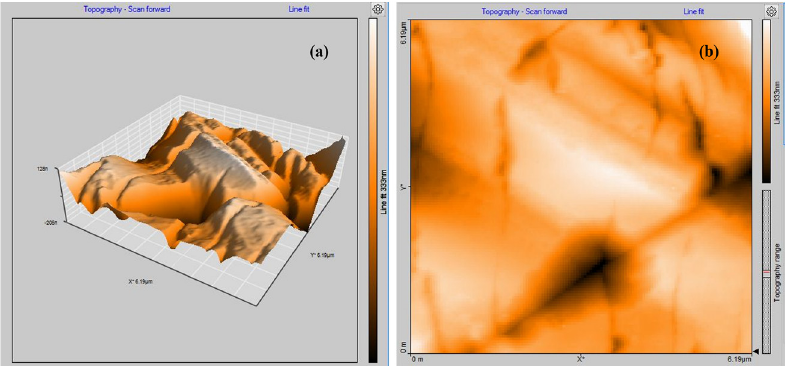
Figure 11. The X* midpoint on the X-axis was represented by 3.095 µm, while the Y* midpoint on the Y-axis was represented by the value 3.095 µm. ( a ) shows the AFM 3D and ( b ) AFM 2D images of